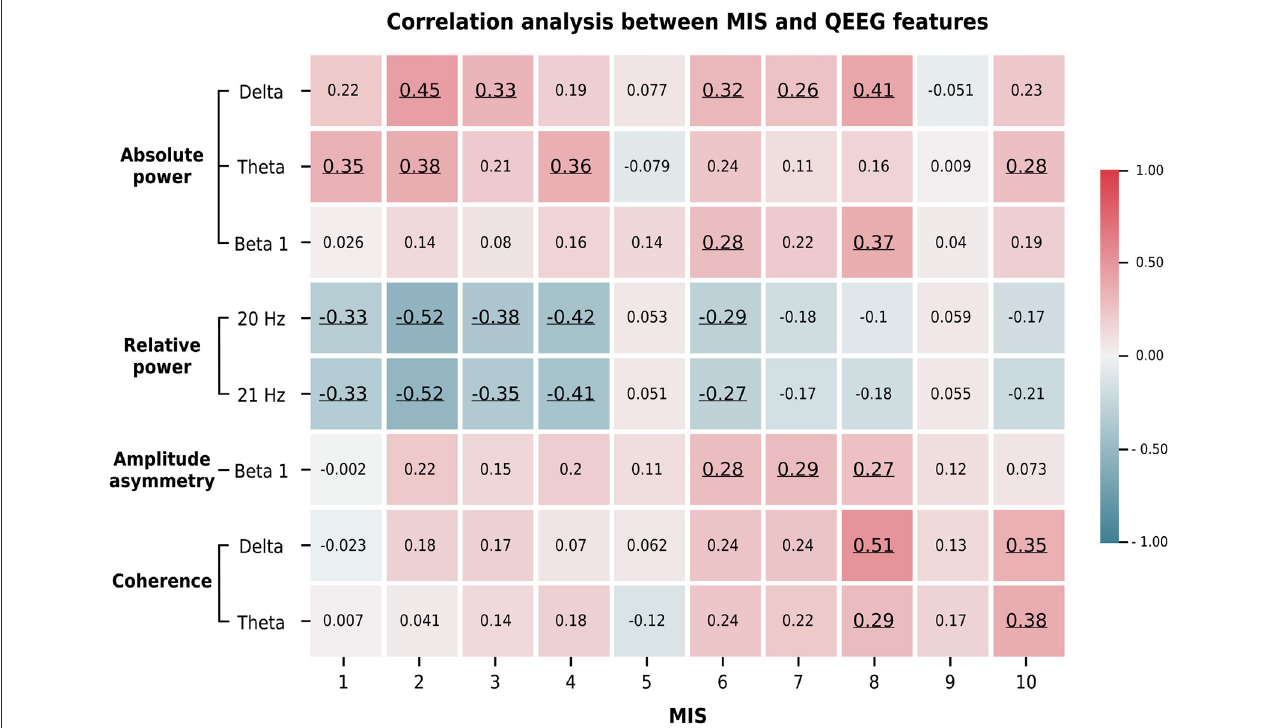
FIGURE6 The average Z-score of the significant QEEG features correlated with the score of some MIS answers. These findings indicate the association between MICS-related factors and QEEG features. The Spearman’s rank correlation coefficients are represented by the color bar. Only significant correlations ( p < 0.05) are underlined. The ten MIS components include: (1) dry weight alterations after dialysis for 3–6 months; (2) quantity of dietary intake; (3) gastrointestinal symptoms; (4) daily functional capacity; and (5) major comorbid conditions, including duration (years) of dialysis; (6) loss of subcutaneous fat; (7) muscle wasting; (8) BMI; (9) serum albumin; and (10) serum total iron binding capacity (TIBC)